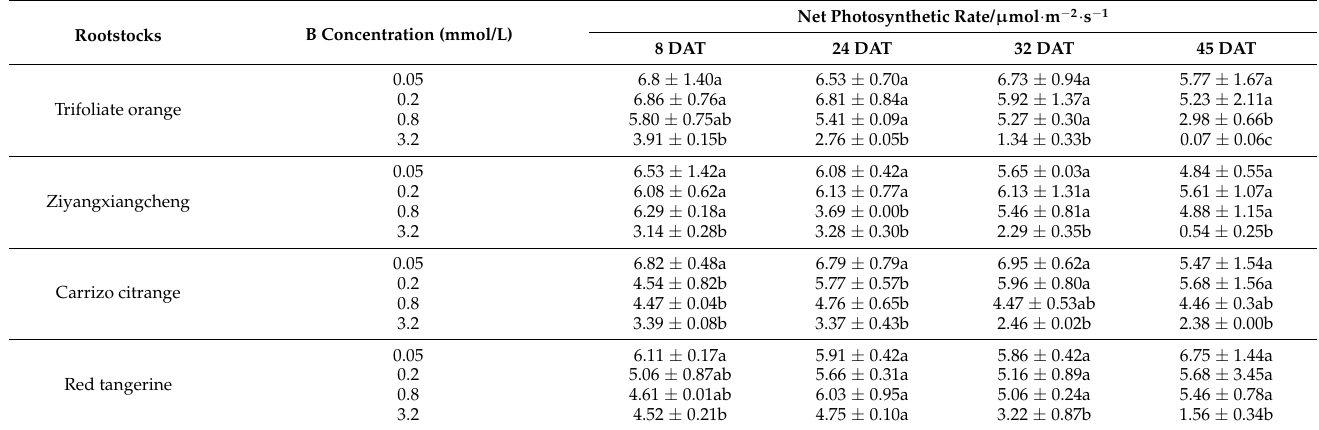
Table 4. The impact of excess B stress on the net photosynthetic rates in the leaves of four citrus rootstock seedlings.